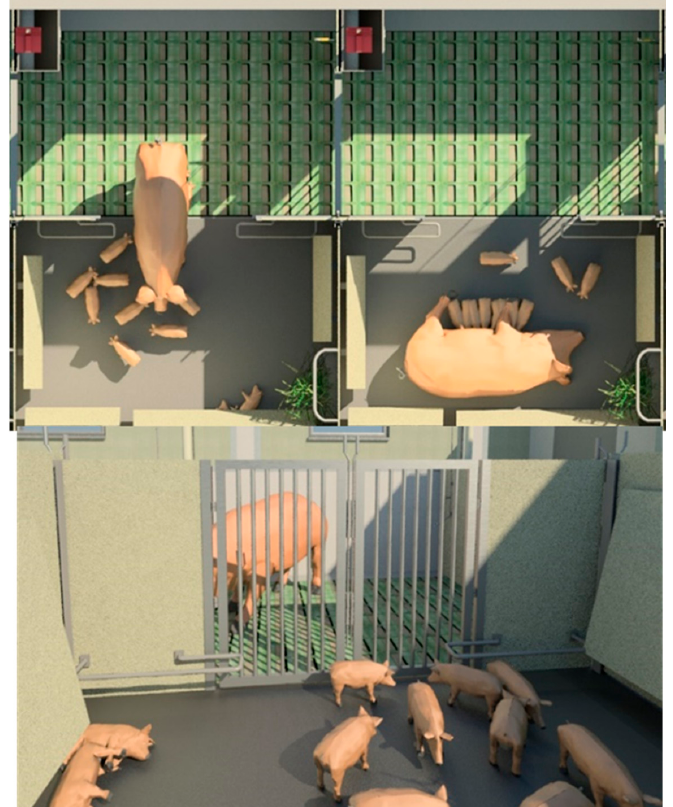
Figure 3. Schematic presentation of how SOWCOMF works in practice when the sow and piglets move around in the pen and when the door between the two areas are closed so that the farmer can handle the piglets without interference of the sow. The drawing was constructed by Elsbeth Morland in Fjøssystemer A/S (2017).